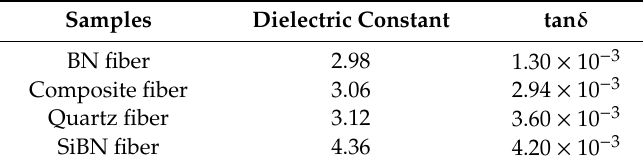
Table 3. Dielectric parameters of the composite fiber and other fibers.